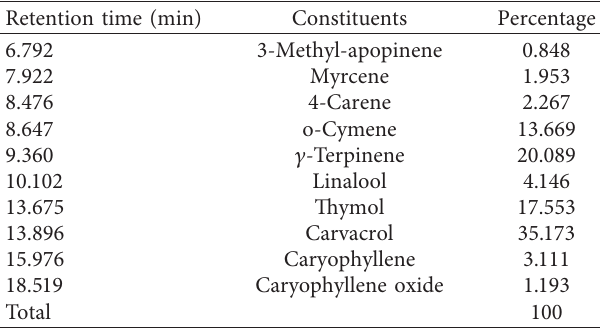
Table 1: Chemical composition of the O. compactum essential oil.